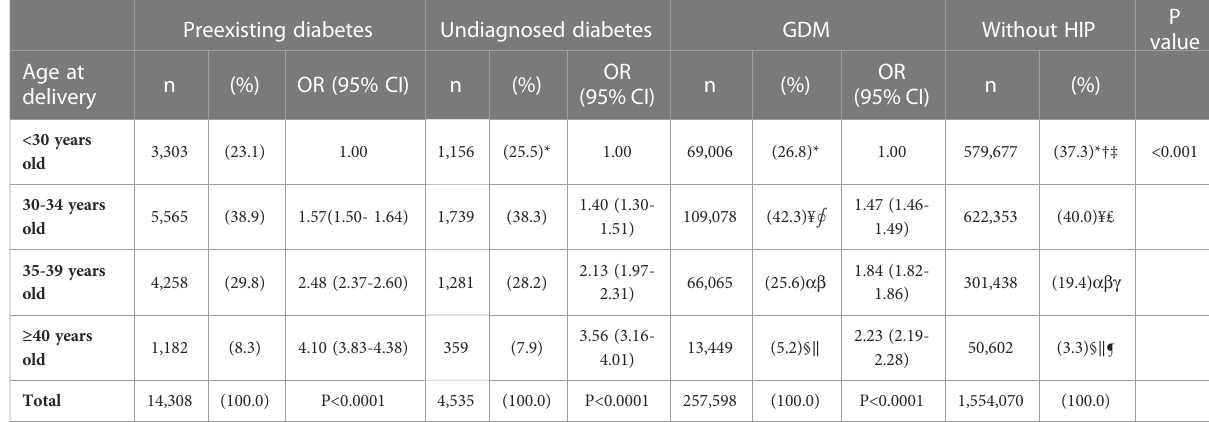
TABLE 2 The distribution of age at delivery in women with preexisting diabetes mellitus, undiagnosed diabetes mellitus, gestational diabetes mellitus (GDM) or without hyperglycemia in pregnancy (HIP) in Taiwan in 2008-2017.